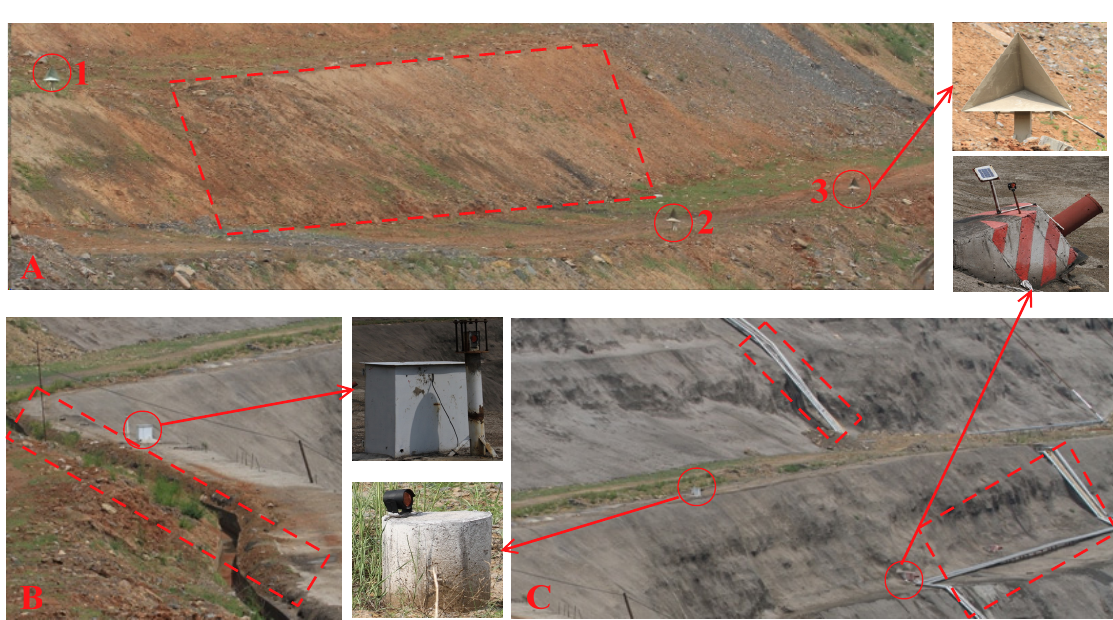
Figure 7. Detail description of the imaging